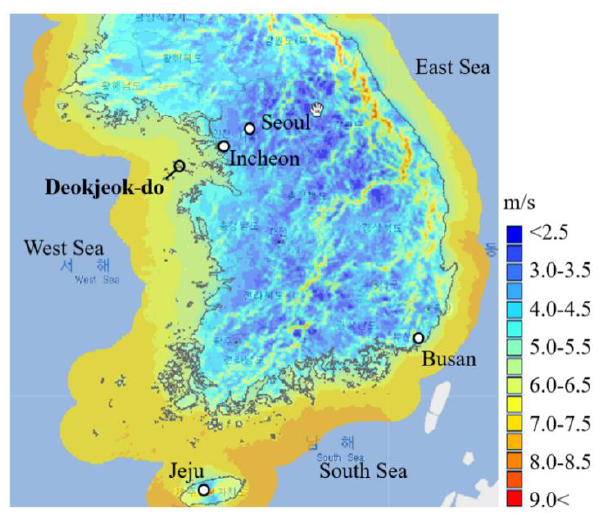
Figure 1. Mean wind speed at 40 m above ground level in South Korea [19].